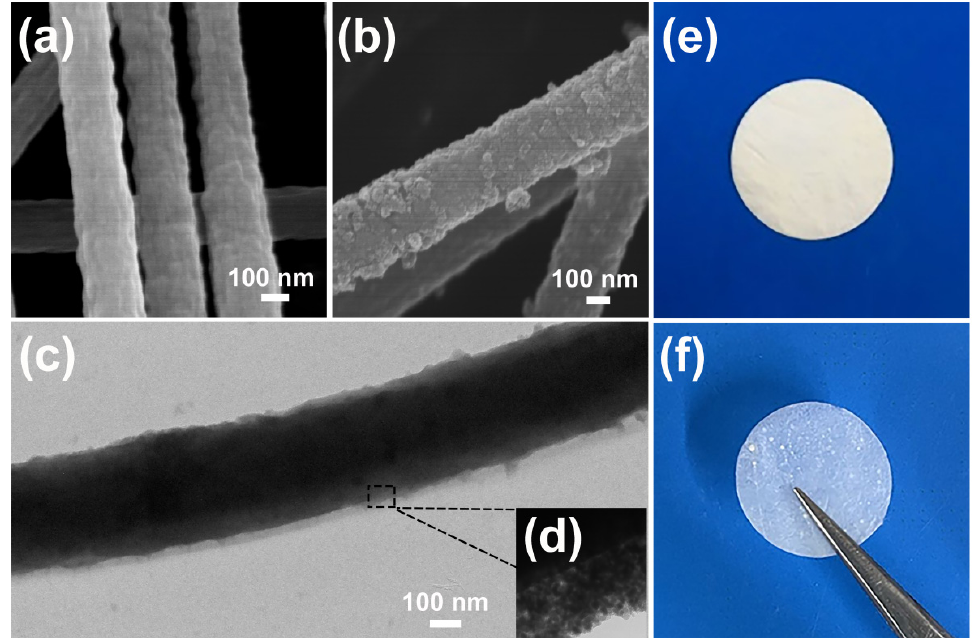
Figure 1. ( a , b ) SEM images of ( a ) PAN nanofiber and ( b ) PAN@PSiO composite nanofiber; ( c , d ) TEM images of PAN@PSiO composite nanofiber; ( e , f ) optical photos of PAN@PSiO composite nanofiber membrane ( e ) before and ( f ) after immersing in the liquid electrolyte till absorbing saturation.